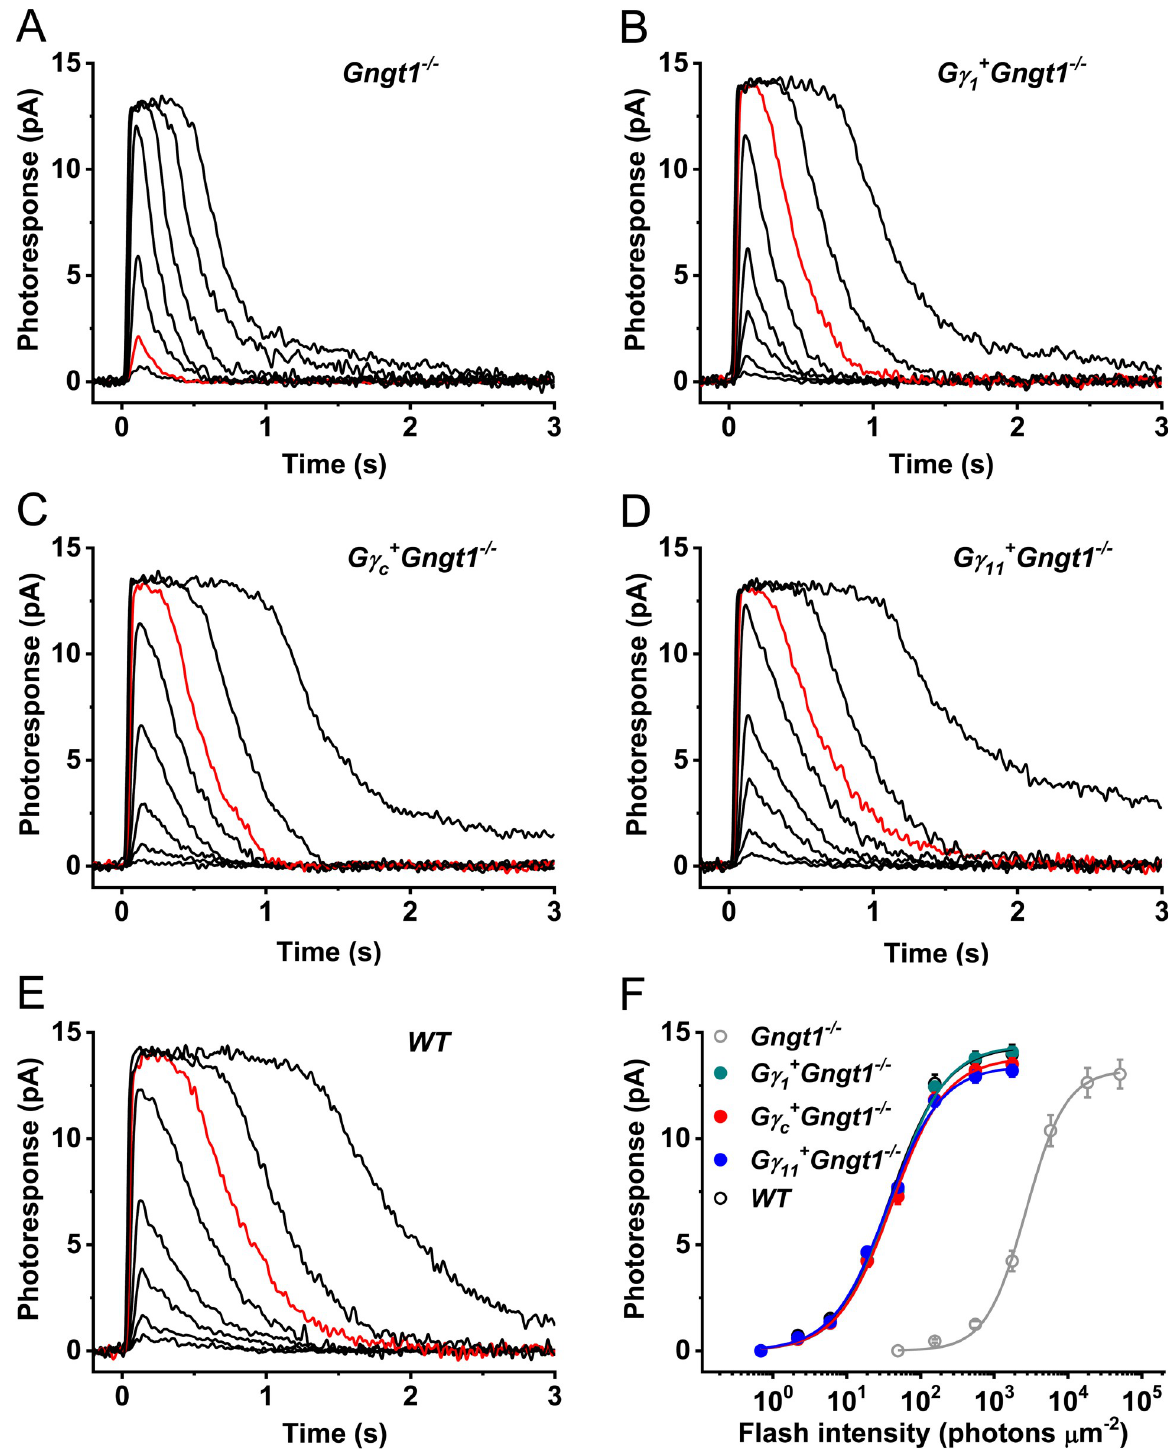
Fig 6. Light responses of rods in control and transgenic mouse lines expressing different G γ -subunits. ( A–E ) Representative families of flash responses from 4–5-week-old control Gngt1 -/- ( A ), G γ 1+ Gngt1 -/- ( B ), G γ c+ Gngt1 -/- ( C ), G γ 11+ Gngt1 -/- ( D ), and wild type ( E ) mouse rods. Test flashes of 500 nm light with intensities of 160, 560, 1.8x10 3 , 5.8x10 3 , 1.8x10 4 , 5.1x10 4 , and 1.6x10 5 photons μ m -2 (for Gngt1 -/- rods) or 2, 6, 19, 50, 160, 560, 1.8x10 3 , and 5.8x10 3 photons μ m -2 (for wild type and all transgenic rods) were delivered at time 0. Red traces show responses to identical light intensity (560 photons μ m -2 ). ( F ) Averaged intensity-response relationships (mean ± SEM) for Gngt1 -/- (n = 11), G γ 1+ Gngt1 -/- (n = 31),